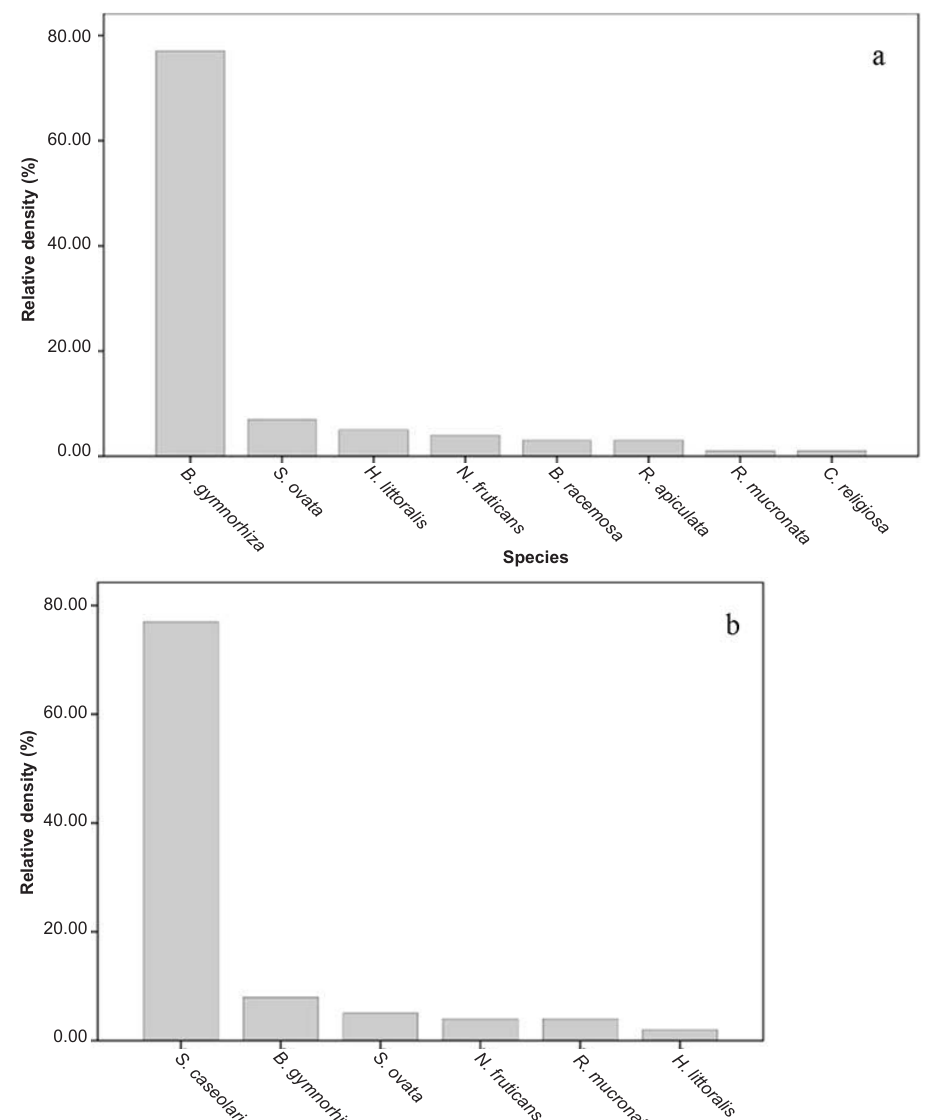
Figure 2. Relative density of mangrove species at Dhili Kadi (a) and Oh Hi Poh (b) on Katchall